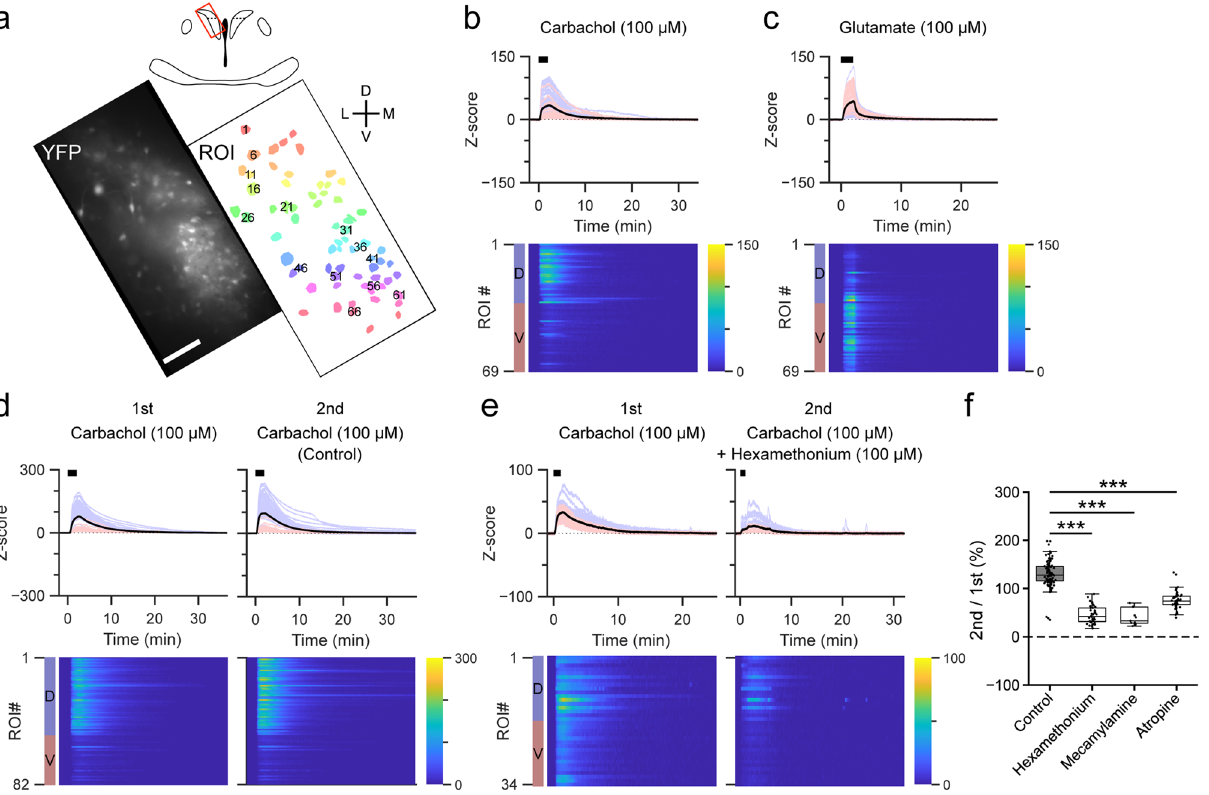
Figure 5. Effect of carbachol on PVN-CRF neurons. ( a ) YFP signal (left) and regions of interest (ROIs, right) of a representative brain slice. The brain region is indicated by the red box in the upper illustration. Numbers superimposed over the ROIs align with the dorsoventral axis (from dorsal to ventral). D dorsal, V ventral, L lateral, M medial, scale bar: 100 μm. ( b – e ) Z-scores of the YFP/CFP ratio recorded from each representative brain slice, ( b ) and ( c ) are from the brain slice shown in ( a ). Upper graphs show traces of individual ROIs (light blue: dorsal PVN, light red: ventral PVN) and mean value (black). Black bars indicate the application timing (2 min) of each substance, carbachol (CCh) in ( b ), ( d ) and ( e ), glutamate in ( c ). Lower heat maps show Z-scores of individual ROIs indicated by the color bars at right. The blue and red color bars at left indicate the dorsal (D) and ventral (V) portions of the PVN. CCh was applied twice in ( d ) and ( e ). The nicotinic acetylcholine (ACh) receptor-selective antagonist hexamethonium was applied 3 min before the second application of CCh in ( e ). ( f ) Box plots of ratio of the area under the curve of the Z-scores of the dorsal PVN between the first and second application of CCh with and without antagonists: hexamethonium (100 μM), the nicotinic ACh receptor- selective antagonist mecamylamine (1 μM) and the muscarinic ACh receptor selective-antagonist atropine (100 nM). Dots show individual data. ***p < 0.001, Kruskal–Wallis test followed by Dunn’s test.